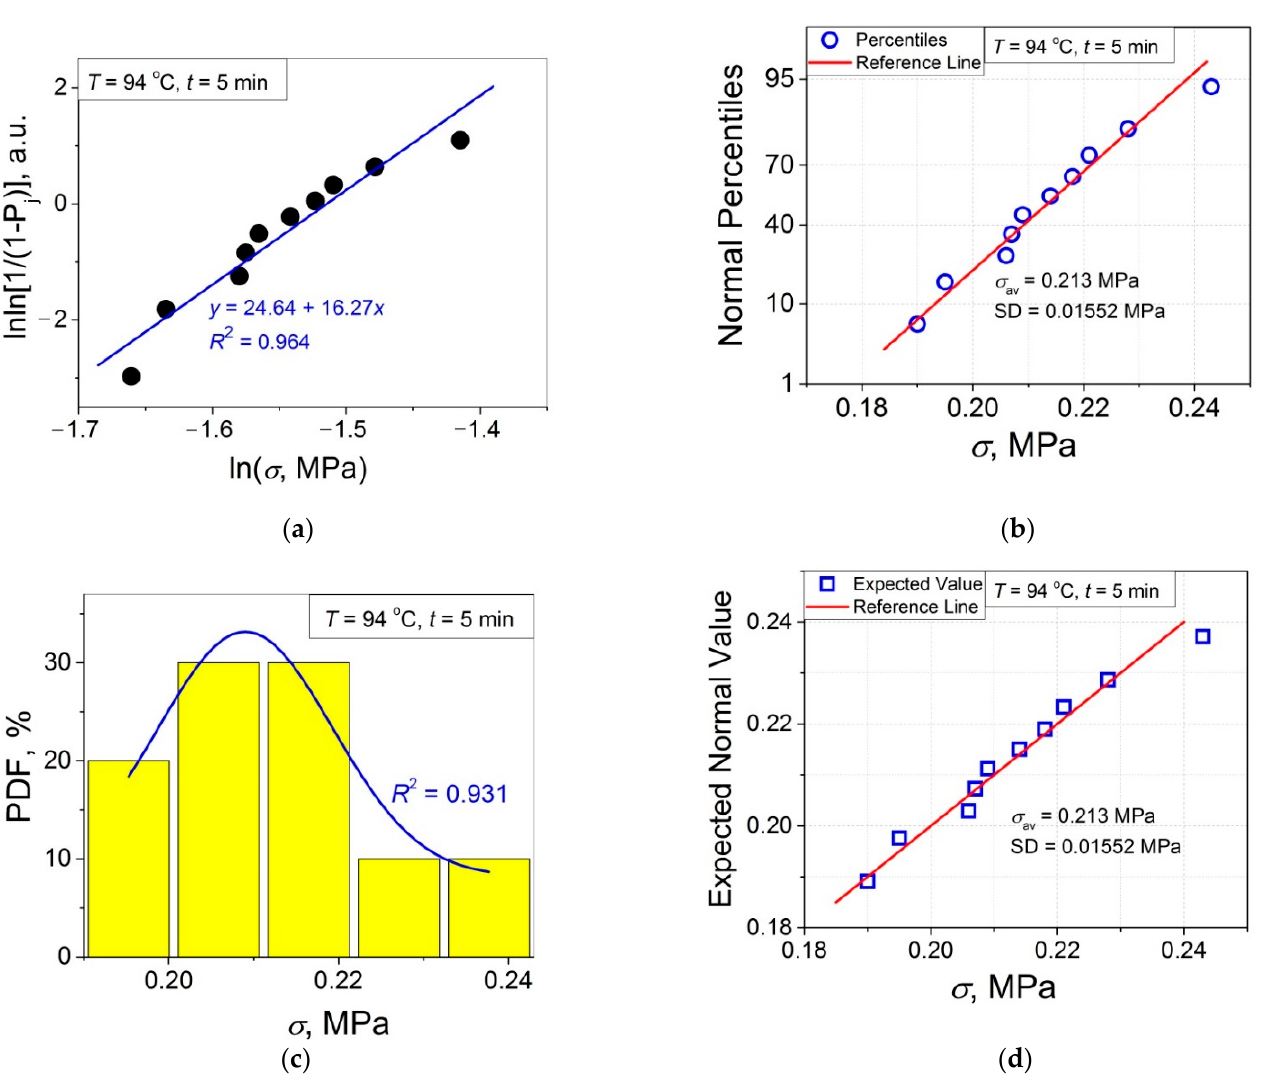
Figure 3. ( a ) Linear regression fit of the lap shear strength σ in Weibull’s coordinates; ( b ) normal probability plot; ( c ) probability density function (PDF) vs. σ fitted with Gaussian function; ( d ) normal quantile–quantile (Q–Q) plot for an amorphous PET–PET interface self-bonded at T = 94 °C for t = 5 min.